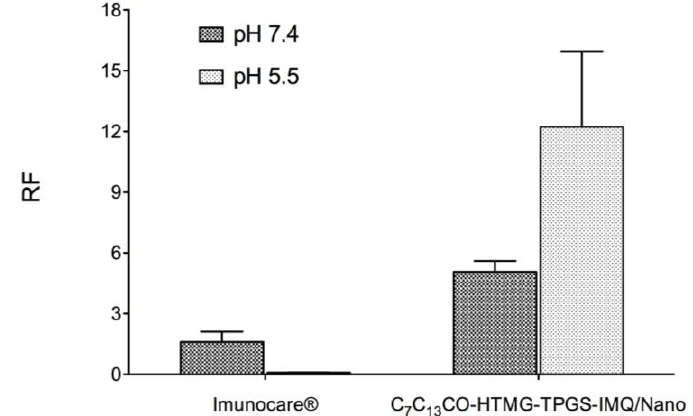
Figure 8. Retention factor (RF) calculated as the amount of drug retained in the skin after application of each formulation with respect to the initial concentration of the drug.